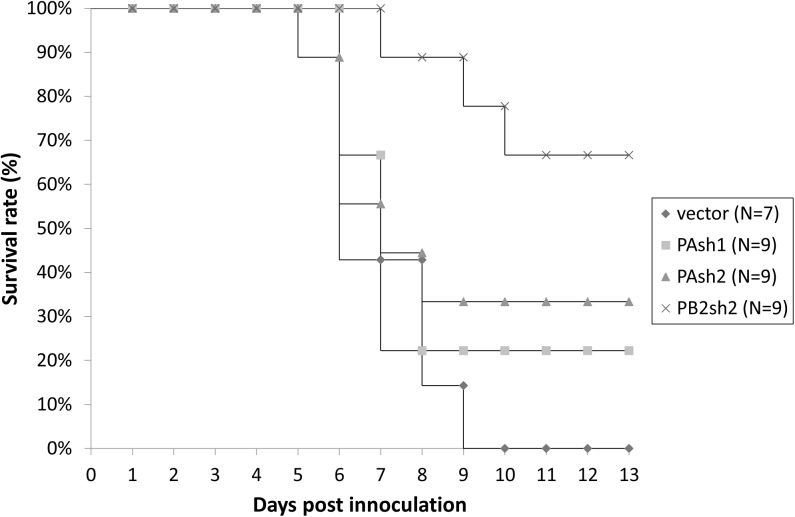
Survival rates of the mice treated prophylactically with shRNA plasmids by intratracheal delivery.Thirty-four mice were treated prophylactically with PAsh1, PAsh2, or PB2sh2 shRNA plasmids via intratracheal administration. The mice were pretreated 24 hours before inoculation with influenza virus. On day 14, only the PB2sh2 shRNA plasmid demonstrated a statistically significant protective effect (p = 0.008).